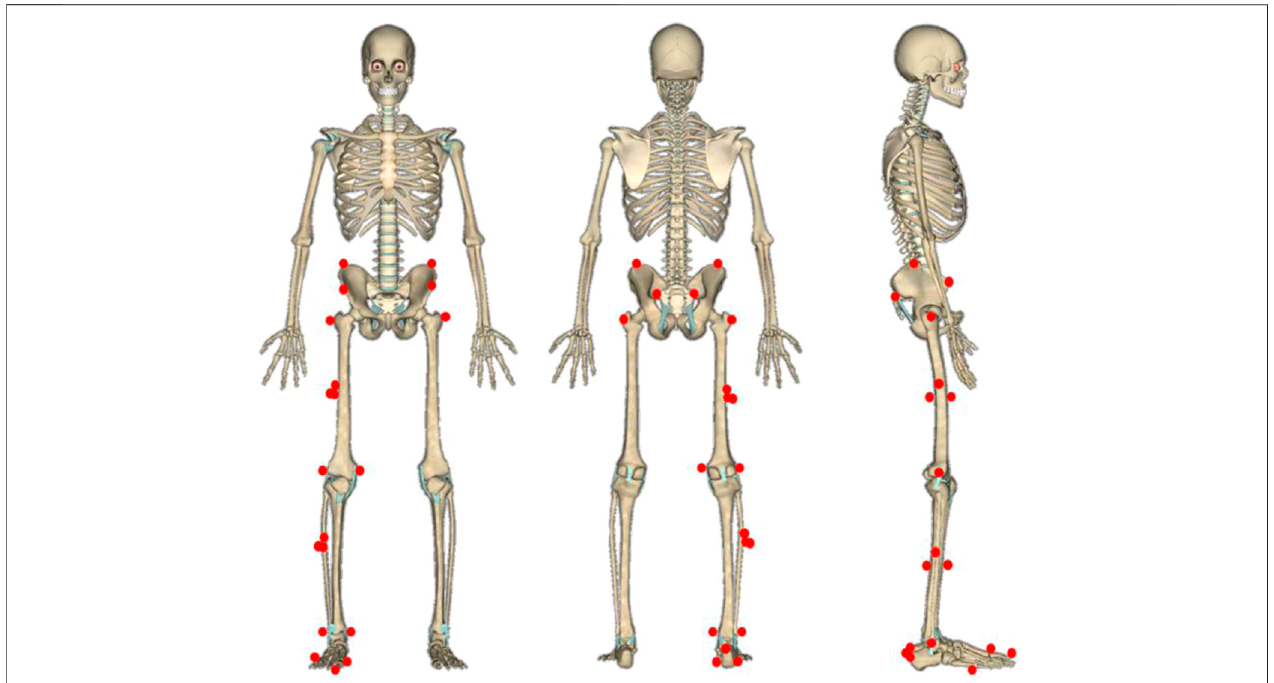
FIGURE 2 | Illustration of re fl ective markers on subjects. From left to right: front view, rear view, and right side view.